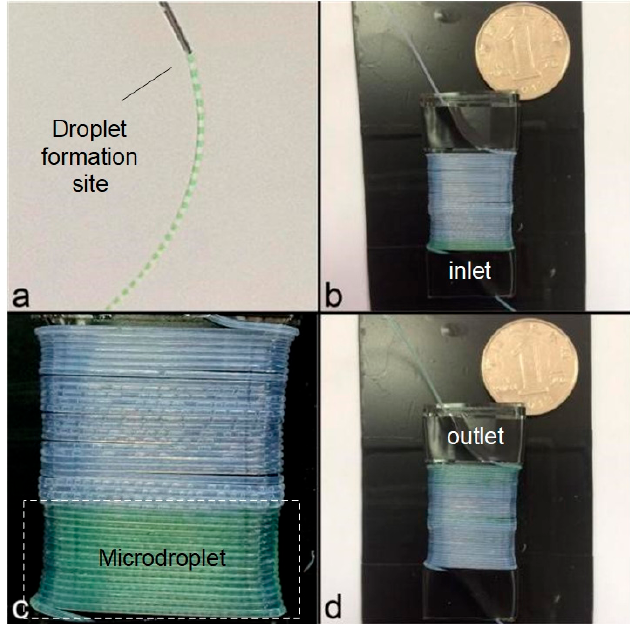
Figure 4. The droplet-based continuous-flow on-chip PCR with the green-color sample flowing at the inlet ( a ), the start ( b ), the middle ( c ), and the end ( d ) of the fluidic